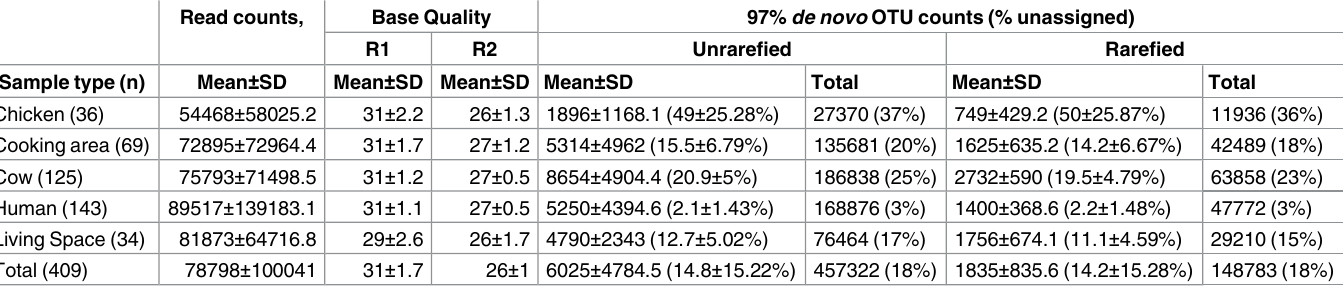
Table 2. Sequencing data quality and de novo Operational Taxonomic Unit (OTU) count results, by sample type. Read